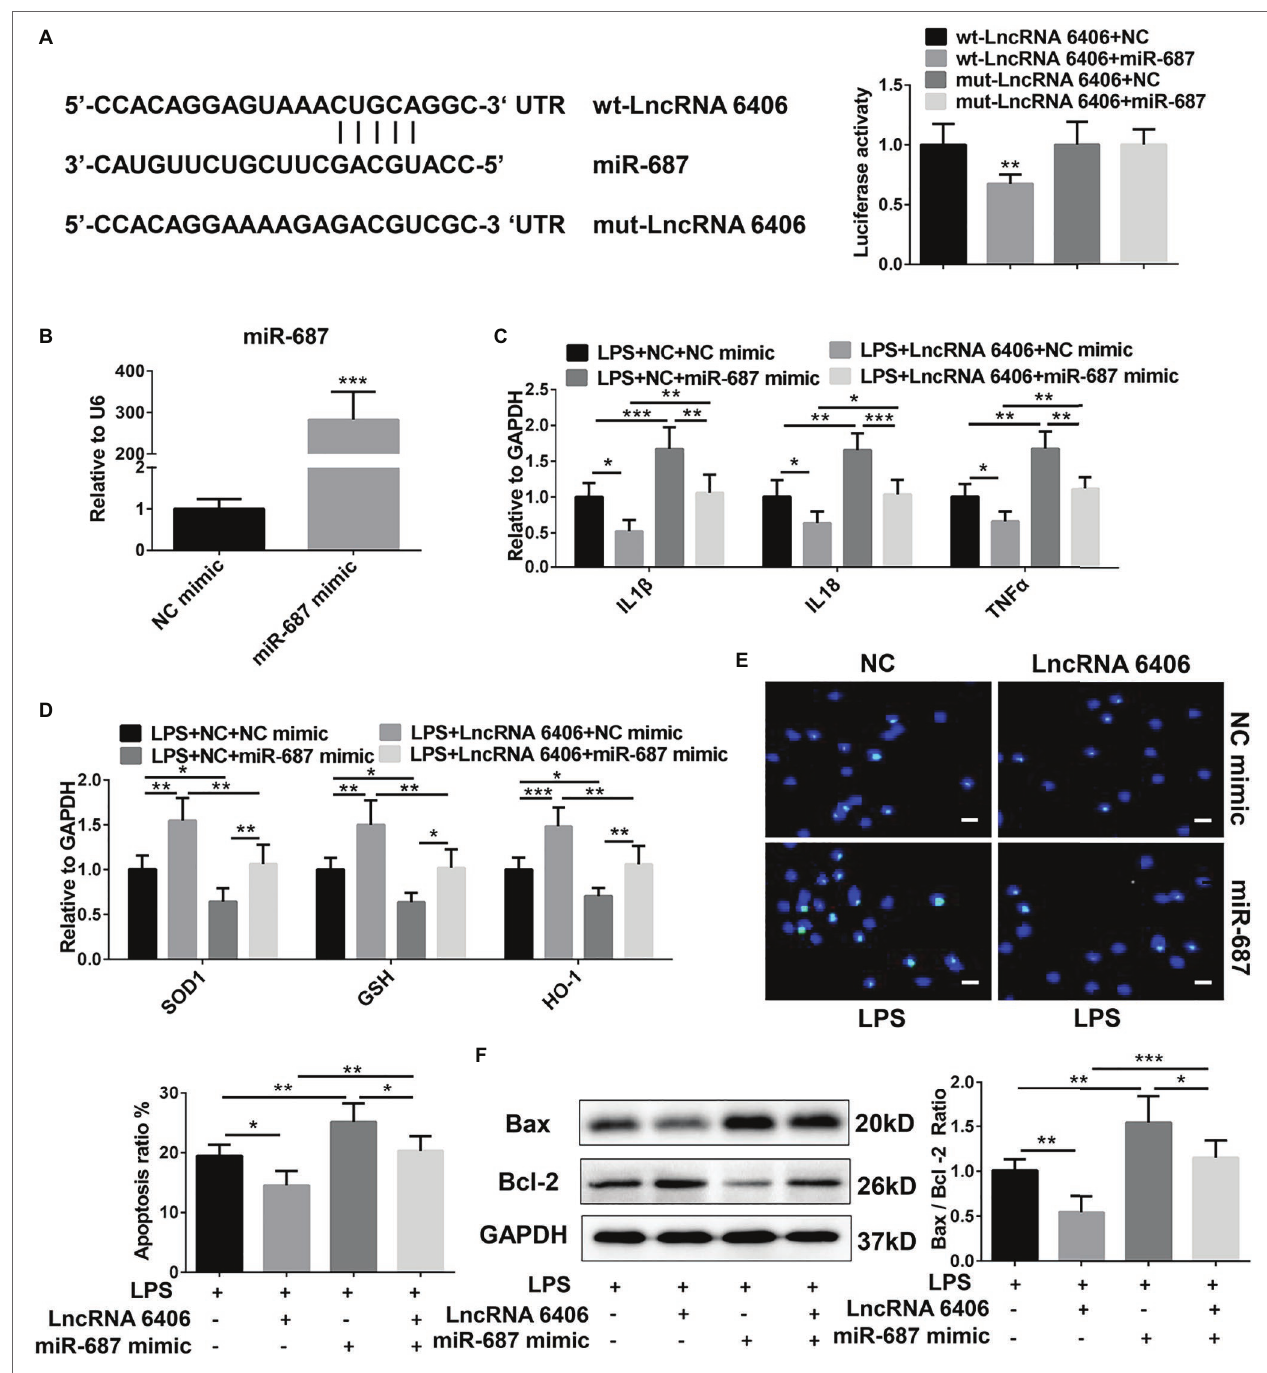
FIGURE 4 | MiR-687 negatively regulated the function of lncRNA 6406. (A) The luciferase reporter assay indicated that miR-687 is a target of lncRNA 6406. (B) The transfection efficacy of the miR-687 mimic was determined by RT-PCR analysis ( n = 6). (C,D) The miR-687 mimic inhibited the lncRNA 6406 overexpression- induced functional changes in the inflammatory response and oxidative stress ( n = 6). (E,F) The miR-687 mimic promoted LPS-induced apoptosis and inhibited the effect of lncRNA 6406 on apoptosis in LPS-stimulated PTEC cells ( n = 6), scale bar = 10 μ m. Each experiment was conducted independently three times. *p < 0.05; **p < 0.01; ***p < 0.001; versus respective